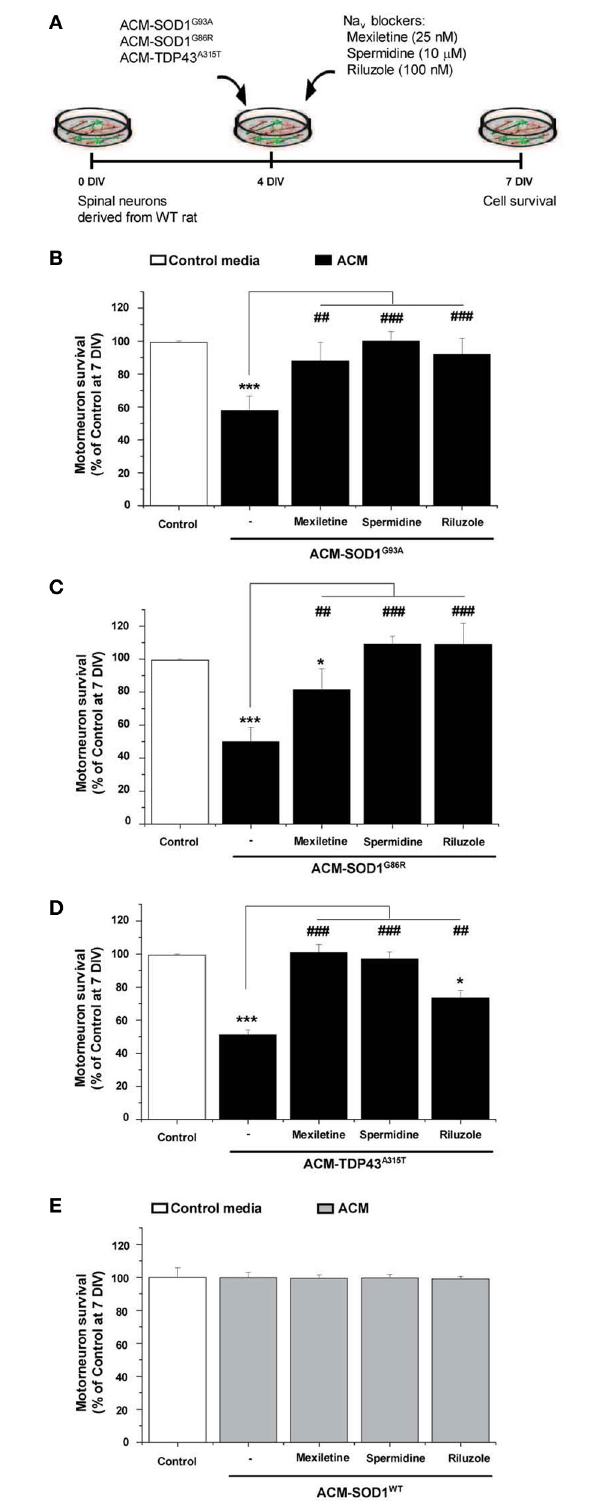
FIGURE 5 | Na v channel blockers prevent motoneuron death induced by ACM-SOD1 G93A , ACM-SOD1 G86R , and ACM-TDP43 A315T . (A) Flow diagram of experiment. ACMs were applied chronically starting at 4DIV